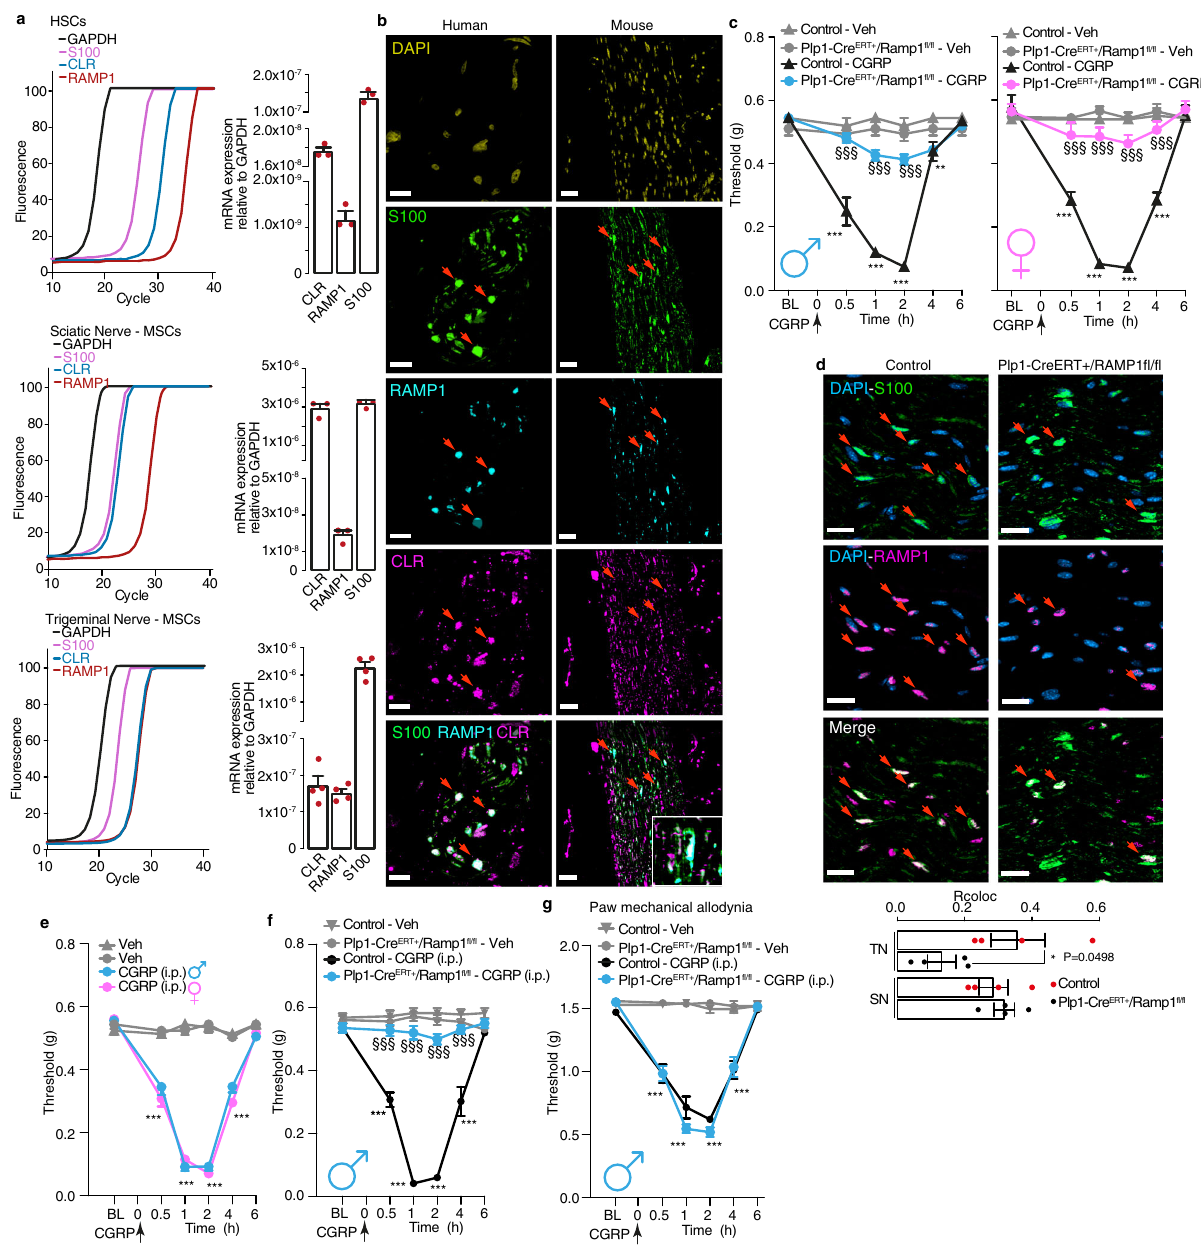
Fig. 1 Schwann cell RAMP1 mediates PMA evoked by CGRP. a Representative real-time PCR plot and cumulative data for GAPDH, S100, CLR and RAMP1 mRNA in HSCs ( n = 3 independent experiments) and MSCs from trigeminal or sciatic nerve (MSCs from sciatic nerve n = 3 independent experiments; MSCs from trigeminal nerve, n = 4 independent experiments). b Representative images of DAPI and immunoreactive S100, RAMP1 and CLR in human and mouse cutaneous nerve bundles (scale, 10 µ m human, 50 μ m mouse) ( n = 3 subjects). c PMA induced by CGRP (1.5 nmol) or vehicle in male and female Plp1-Cre ERT + / Ramp1 fl / fl and Control mice treated with periorbital 4-OHT ( n = 8 mice per group). d Representative images and colocalization value (Rcoloc) of S100 and RAMP1 in periorbital nerve and sciatic nerve trunks from Plp1-Cre ERT + ;Ramp1 fl / fl and Control mice (scale, 20 μ m) ( n = 4 replicates). TN (trigeminal nerve), SN (sciatic nerve). e PMA induced by intraperitoneal (i.p.) CGRP (0.1 mg/kg) or vehicle in male and female C57BL/6 J mice ( n = 8 mice per group). f PMA and ( g ) paw mechanical allodynia induced by intraperitoneal (i.p.) CGRP (0.1 mg/kg) or vehicle in male Plp1-Cre ERT + / Ramp1 fl / fl and Control mice ( n = 8 mice per group) treated with periorbital 4-OHT. Mean±SEM. * P < 0.05, ** P < 0.01, *** P < 0.001 vs. Veh, Control-Veh, and TN-Control, §§§ P < 0.001. vs. Control-CGRP. 2-way ( c , e , f , g ) or 1-way (d) ANOVA, Bonferroni correction. Source data are provided as a Source Data fi le. (~10 min) nociceptive behavior (Fig. 2a) and, like CGRP, caused which prevented SP-evoked PMA (Fig. 2g), failed to diminish prolonged (~4 h) PMA (Fig. 2b). Allodynia was detected in the capsaicin-evoked acute nociception and PMA (Fig. 2h, Supple- periorbital area but not in the hind paw (Supplementary Fig. 2a), mentary Fig. 2b). The histamine H 1 receptor antagonist, aste- indicating a local action. TRPV1 deletion ( Trpv1 − / − mice) mizole, inhibited SP-evoked PMA (Supplementary Fig. 2c) but (Fig. 2c, d) or pretreatment with the TRPV1 antagonist capsa- did not affect CGRP- or capsaicin-evoked PMA (Supplementary zepine (Fig. 2e, f), prevented acute nociception and PMA. An Fig. 2d, e). Pretreatment with the CLR/RAMP1 antagonists, antagonist (L-733,060) of the SP neurokinin 1 (NK 1 ) receptor, CGRP8-37 or olcegepant, prevented PMA (Fig. 2i, j) but not acute NATURE COMMUNICATIONS| (2022) 13:646